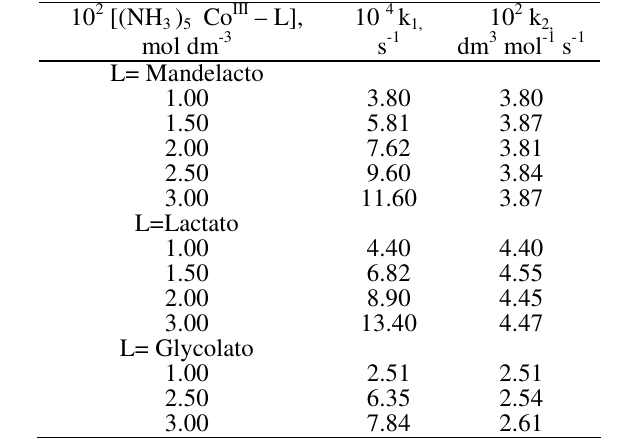
SO ] =1.00 mol dm -3 [Na LS]=2.00 x 10 -3 mol dm -3 2 4